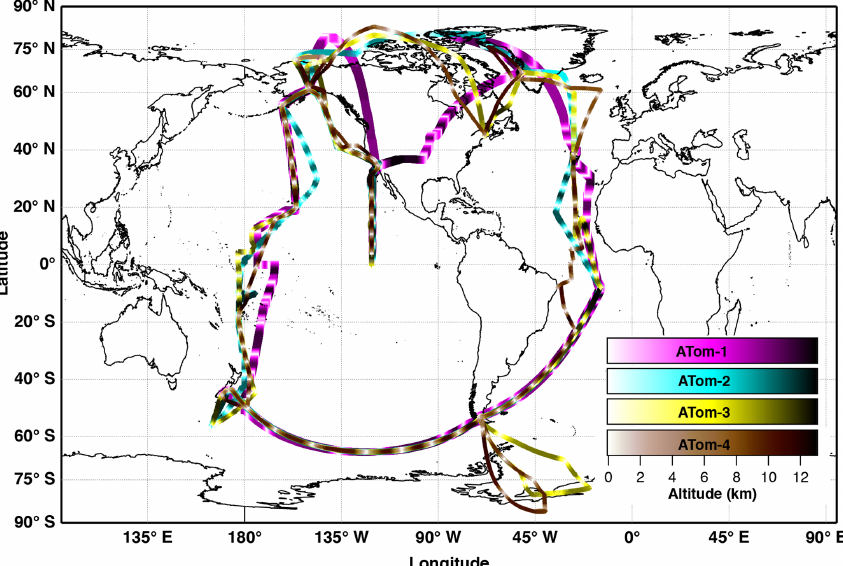
Figure 1. Flight tracks of the NASA DC-8 for ATom-1 (magenta), ATom-2 (cyan), ATom-3 (yellow), and ATom-4 (brown) shaded to show altitude.